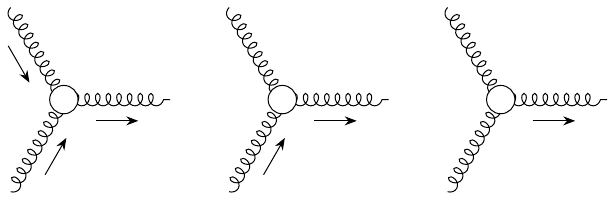
Figure 1 . The three versions of the vertex X others are (cid:13)owed (or regular)